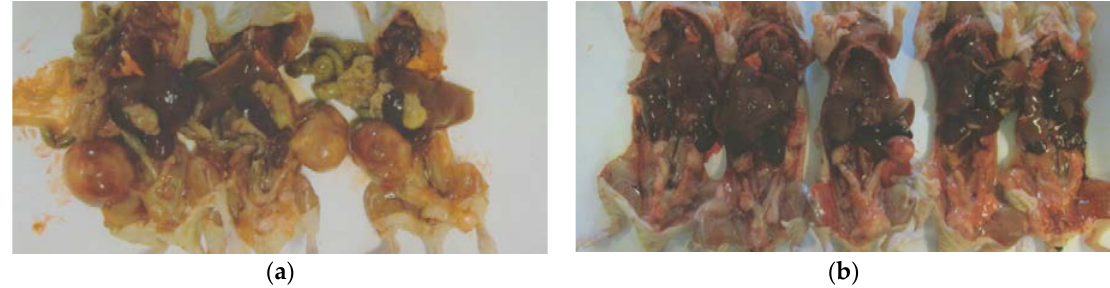
Figure 2. Gross photographs of mice in respective groups. ( a ) Control group, ( b ) EPQ group.